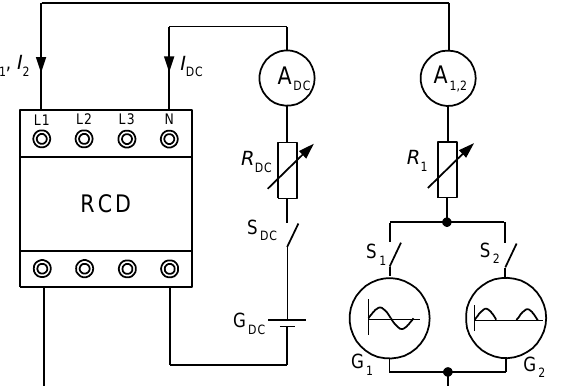
Figure 5. Simplified structure of the laboratory setup for RCD testing under residual currents with DC component or pure direct currents. A DC —ammeter for DC currents; A 1,2 —ammeter for AC currents and pulsating DC currents; G DC —generator for producing smooth DC component; G 1 —generator for producing AC sinusoidal component; G 2 —generator for producing pulsating DC component; R DC , R 1 —rheostats for limiting values of the testing current; S DC , S 1 , S 2 —switches; I DC —smooth DC component; I 1 —AC sinusoidal component; I 2 —pulsating DC component; RCD—tested residual current device.